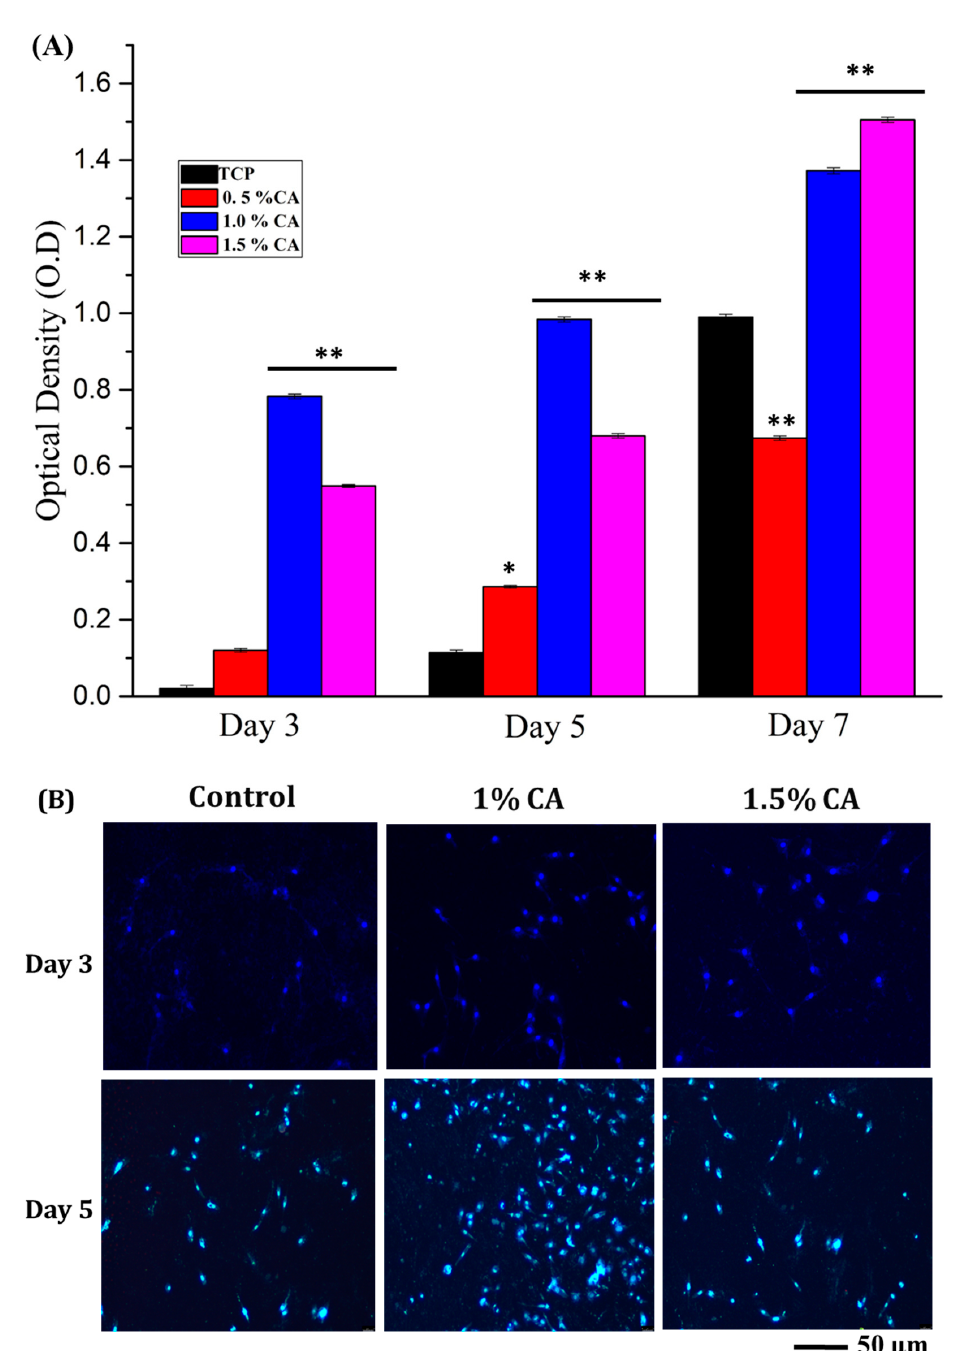
Figure 7. ( A ) MTT assay of NIH3T3 cell line for the developed C ‐ spun matrices for days 3, 5, and 7. TCP—tissue culture plate; * p < 0.05 and ** p < 0.01 compared to TCP. ( B ) Cell growth and proliferation of NIH3T3 cell line on c-spun PCL and PCL-CA fibrous mats (CA: 1 and 1.5%) on days 3 and 5 (blue fluorescence from DAPI staining for nucleus).